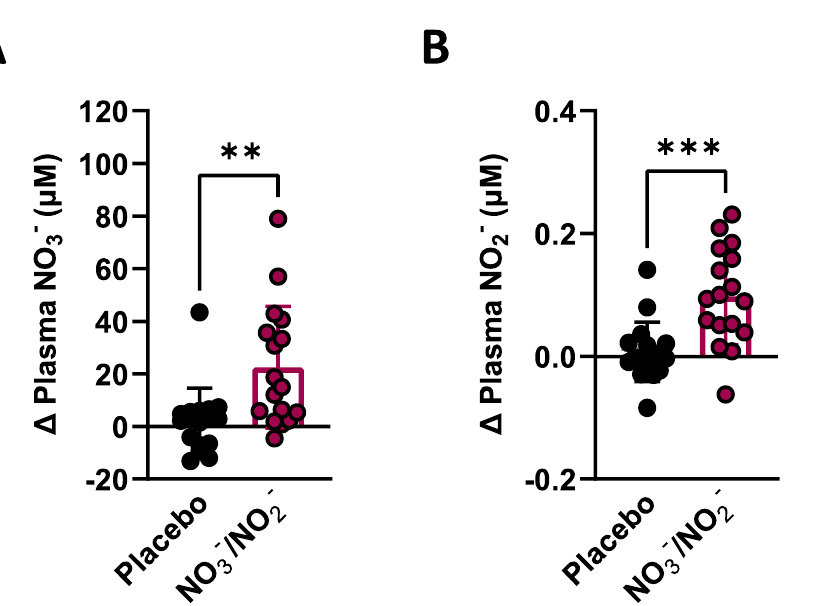
Figure 3. Plasma nitrate (NO 3 − ) and nitrite (NO 2 − ) levels after combined NO 3 − /NO 2 − supplementation vs. Placebo in T2DM participants. ( A ) ANCOVA results, using pre-supplementation values of NO 3 − as a covariate, showing individual changes (post–pre) for plasma NO 3 − from primary group of T2DM subjects (N = 18/condition). ( B ) ANCOVA results, using pre-supplementation values of NO 2 − as a covariate, showing individual changes (post–pre) for plasma NO 2 − as shown in A. Data are presented as mean ± SD. ** p < 0.01; *** p < 0.001.